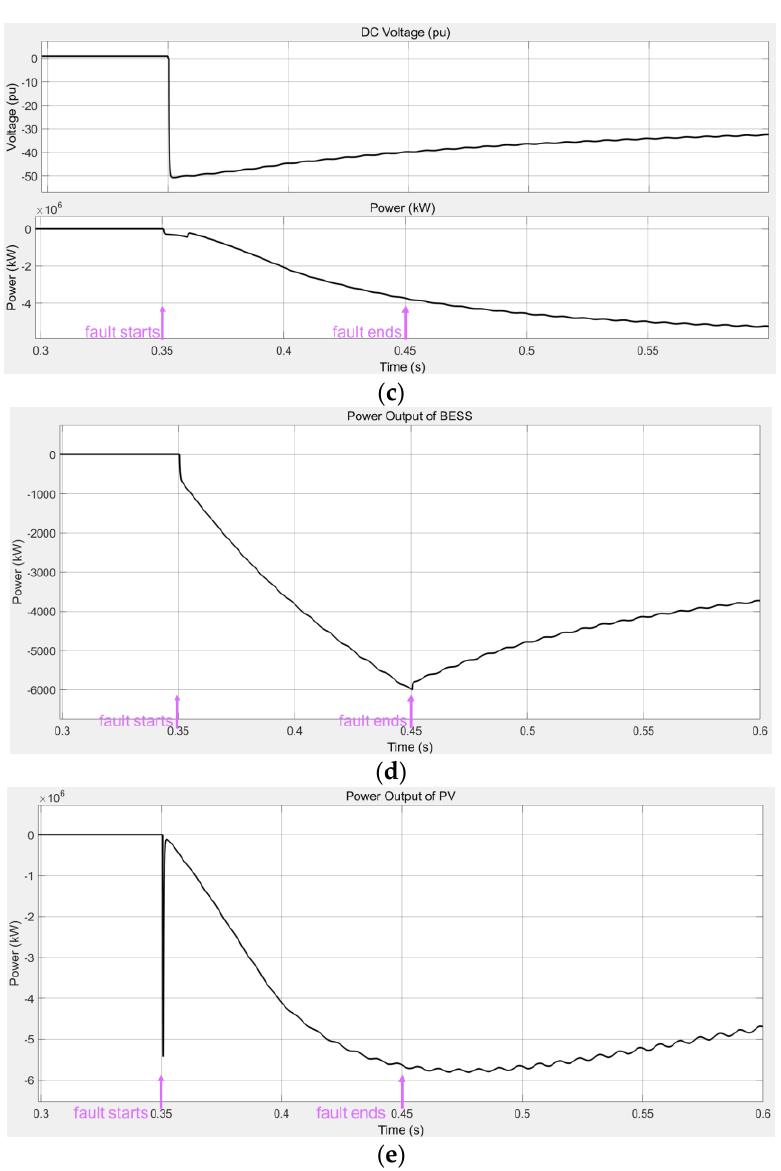
Figure 12. Performance when a ground fault occurs on the DC side. ( a ) Signals at Bus 6; ( b ) Signals at AC/DC interfacing Bus 8; ( c ) Signals at DC bus; ( d ) Power output of the BESS; ( e ) Power output of the PV generation.